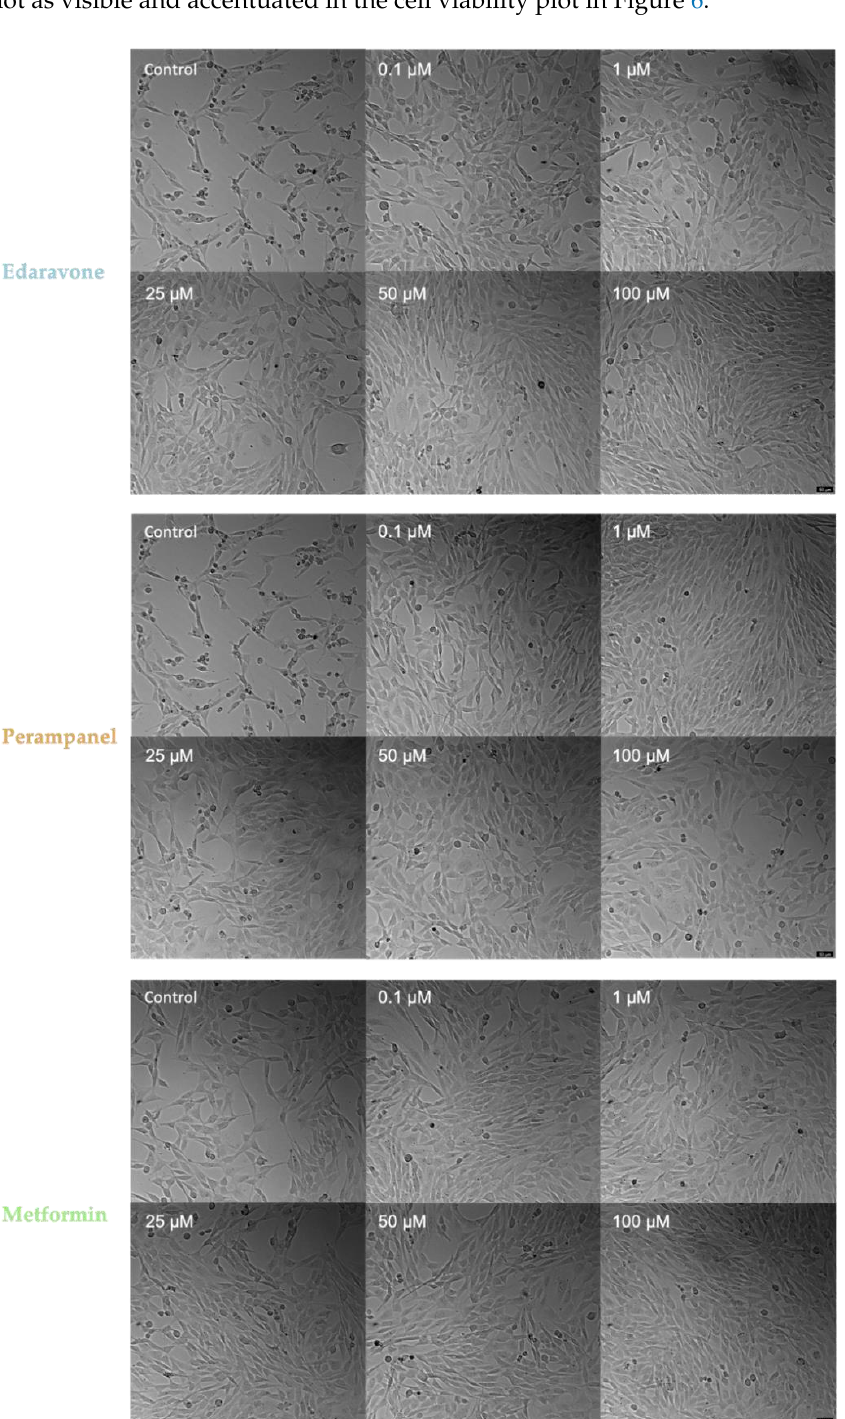
Figure 9. Microscopic representative images of HT-22 hypoxia control cells and HT-22 cells exposed for 48 h to hypoxia and drug concentrations, ranging from 0.1 to 100 µ M, of edaravone, perampanel, and metformin. Images of cell morphology were obtained using a Leica microscope equipped with Leica LAS X imaging software v3.7.4 (Leica Microsystems, Wetzlar, Germany) from three independent experiments. Scale bar: 50 µ